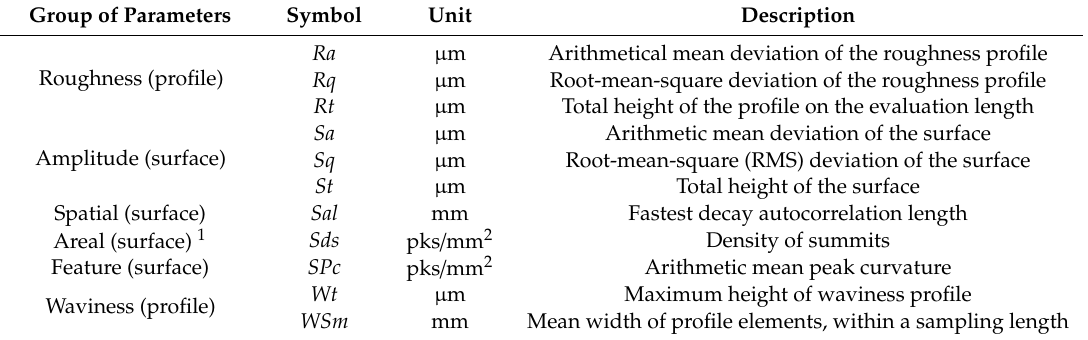
Table 1. Characteristics of roughness and waviness parameters calculated during experimental studies. Group of